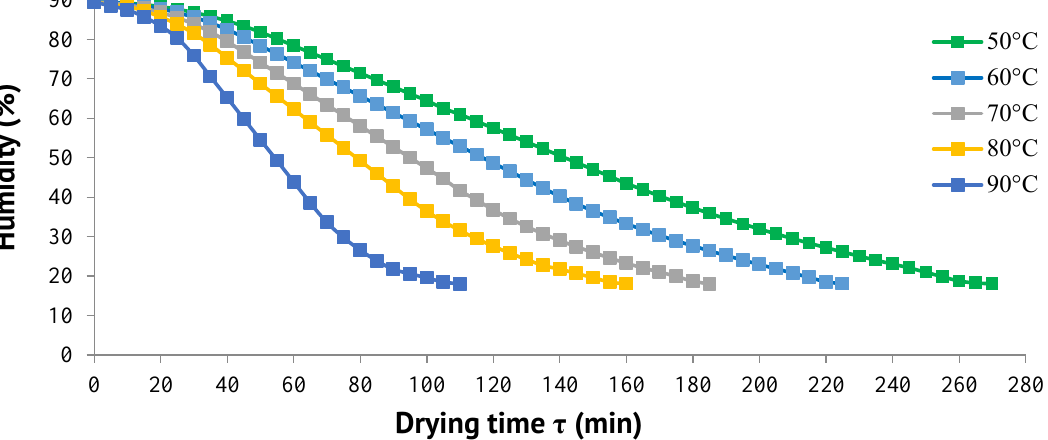
Figure 3. SPRINGCREST peaches different thermal agent temperatures drying curves (Thermal agent velocity 2.0 m . s - 1 , thermal agent relative humidity 60.0%, slices thickness 3 . 10 -3 m).